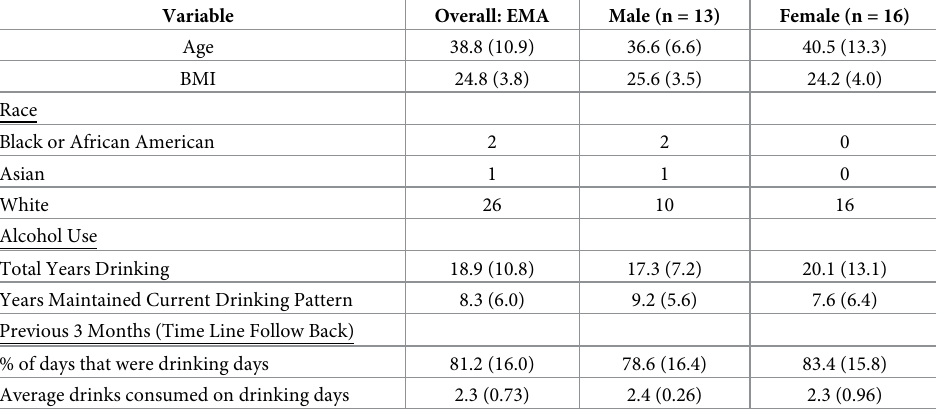
Table 1. Sample characteristics: Mean (SD) or